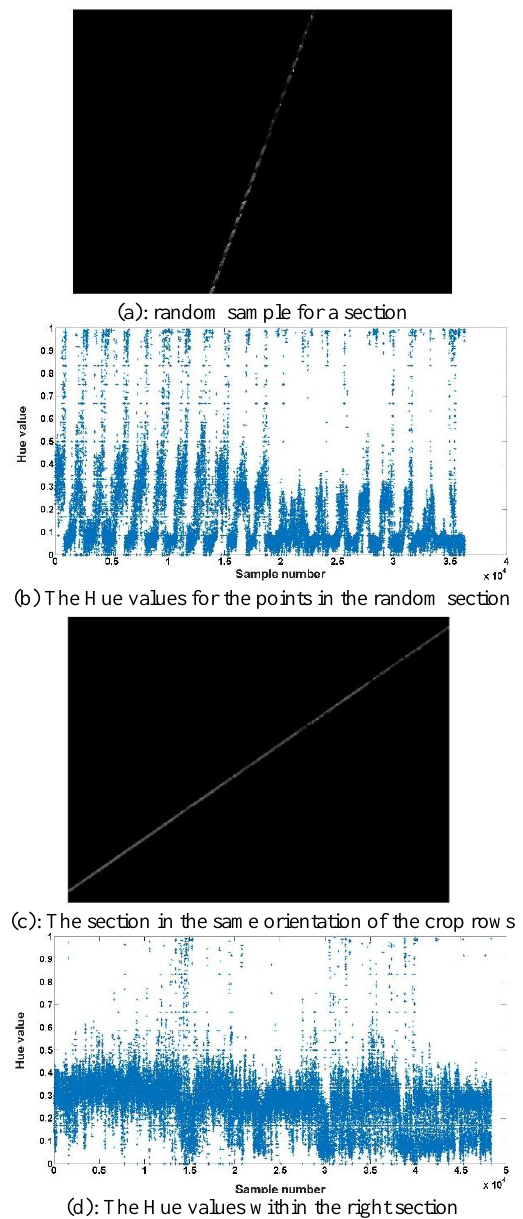
Figure 4. Two cases for sections in the Hue image along